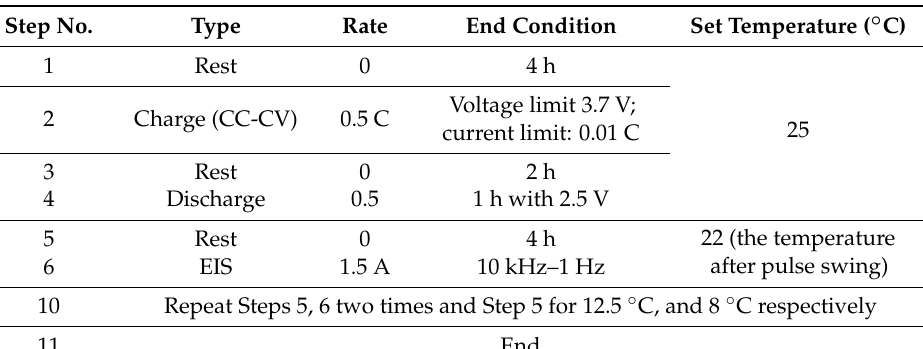
Table 6. The battery impedance test procedures